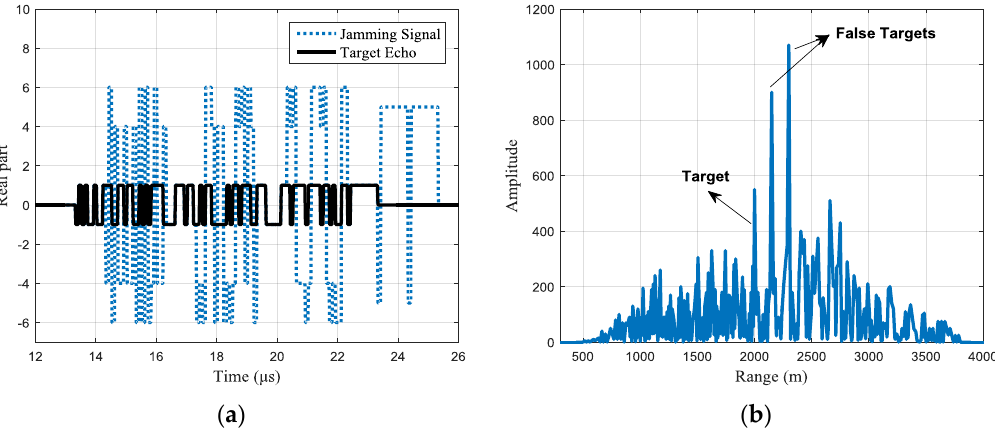
Figure 4. Jamming effect of common binary phase-coded signal. ( a ) The real part of the received signals and ( b ) pulse compression of the received